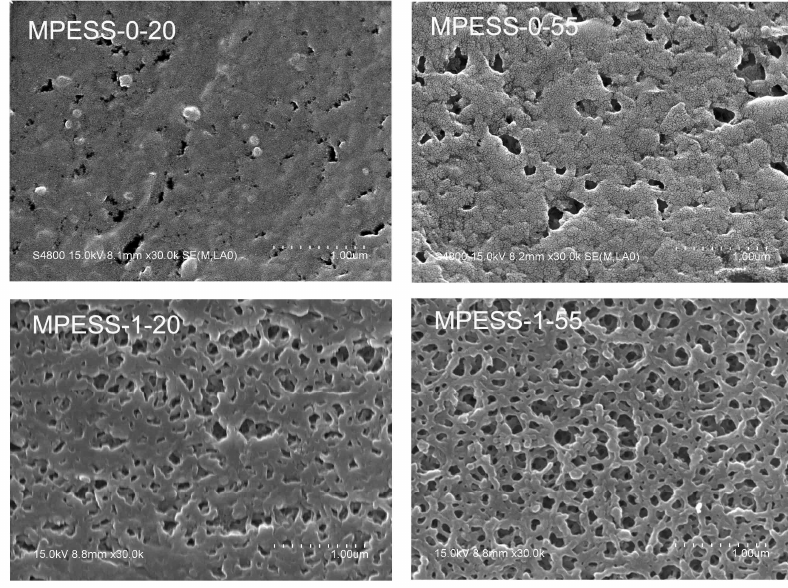
Figure 5. SEM micrographs of the outer surfaces of PES hollow fiber membranes.